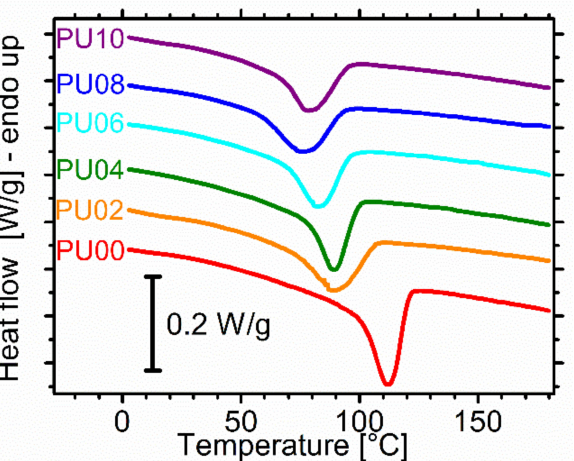
Figure 8. DSC cooling curves recorded with all materials under investigation. The curves have been translated for